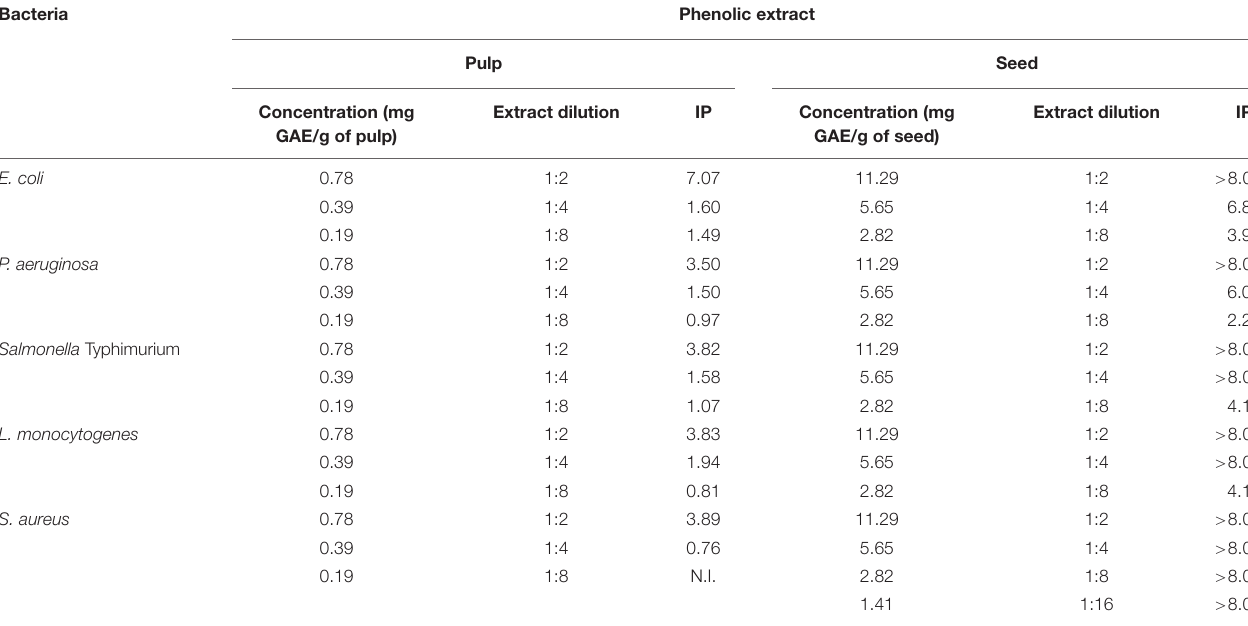
TABLE 3 | Inhibitory potential (IP) of the pulp and seed phenolic extracts of S. cumini (L.) Skeels against the evaluated bacteria. Bacteria Phenolic extract Pulp Seed Concentration (mg Extract dilution IP Concentration (mg Extract dilution GAE/g of pulp) GAE/g of seed)